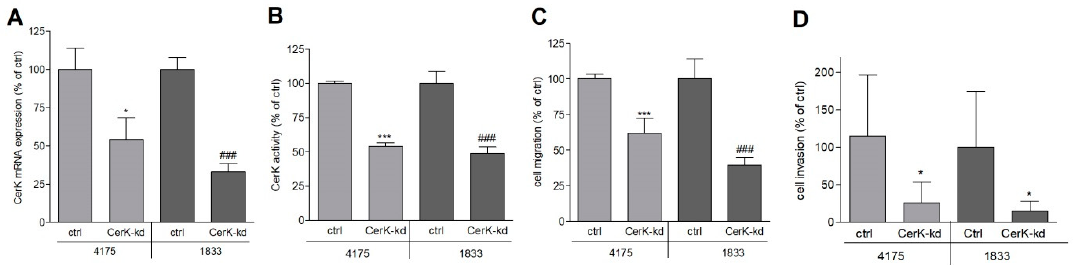
Figure 4. Effect of CerK knockdown on cell migration of metastatic MDA-MB-231 cells. ( A , B ) Lung metastatic (4175) and bone metastatic (1833) MDA-MB-231 cells that were stably transduced with a lentiviral construct containing CerK small hairpin RNA (shRNA) (CerK-kd) or a control construct (ctrl) were analyzed for CerK mRNA expression ( A ) and CerK activity ( B ), as described in the Methods section. ( C ) 5 × 10 4 control cells (ctrl) or the CerK-kd 4175 and 1833 cells were seeded onto transwell filters and allowed to migrate for 20 h in DMEM containing 1% FBS. ( D ) 5 × 10 4 control cells (ctrl) or the CerK-kd 4175 and 1833 cells were seeded onto Matrigel-precoated transwell filters, as described in the Methods section, and incubated for 24 h in growth medium to allow for invasion. Migrated and invaded cells were quantified as described in the Methods section. Representative pictures are shown in supplementary Figures S5 and S6. Data are expressed as percentage of ctrl cells and are means ± SD ( n = 3 for A – C , n = 6 for D ). * p < 0.05, *** p < 0.001 compared to 4175 ctrl cells; ### p < 0.001 compared to 1833 ctrl cells.